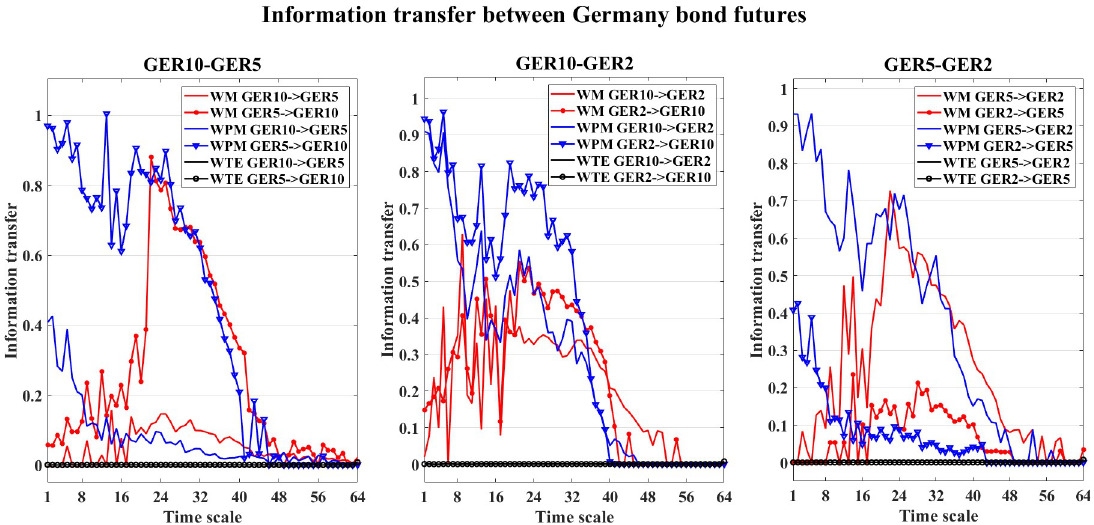
Fig 35. Information transfer between the Germany bond futures. In this figure, the three graphs show the information transfer between the three Germany bond futures (GER10, GER5, GER2). In each graph, the WM (red), WPM (blue) and WTE (black) information transfer values are plotted against different time scales s